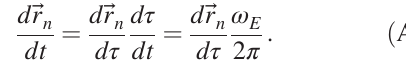
Inserting the same reference LHC beam parameters as before yields the estimate B 0 ¼ 137 × 10 − 4 T ¼ 137 Gauss. Eq. (A3) yields a maximum angular oscillation frequency ω ≈ 9 . 0 × 10 11 rad = s, corresponding to T (cid:3) ≈ 8 . 1 K, E p ¼ 5 σ =c , Eq. (A15) yields and, with a ramp time T z ramp τ ≈ 181 . On the other hand, for an O 2 molecule, the peak max angular oscillation frequency is ω B ¼ 4 . 27 × 10 10 rad = s, ≃ 8 . 6 . Inspecting corresponding to T (cid:3) μ ¼ 0 . 11 K and τ max ≃ 181 we find A ≃ 0 . 5 , and, Fig. 25, for example, at τ max inv for the perpendicular dipole moment at the end of the field ramp, i.e., at the passage of the bunch center, this implies p ≃ 0 . 4 , which corresponds to a residual misalign- n; ⊥ ; max ment of Δ θ ≃ 23 . 5